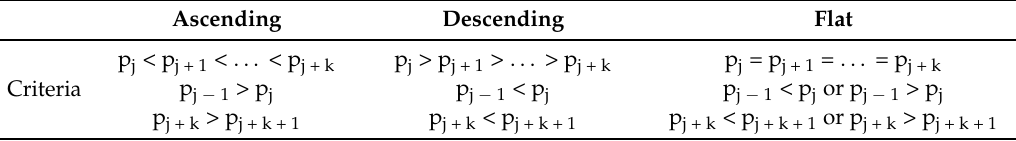
Table 2. The 2-D table corresponding to the curve in Figure 4.